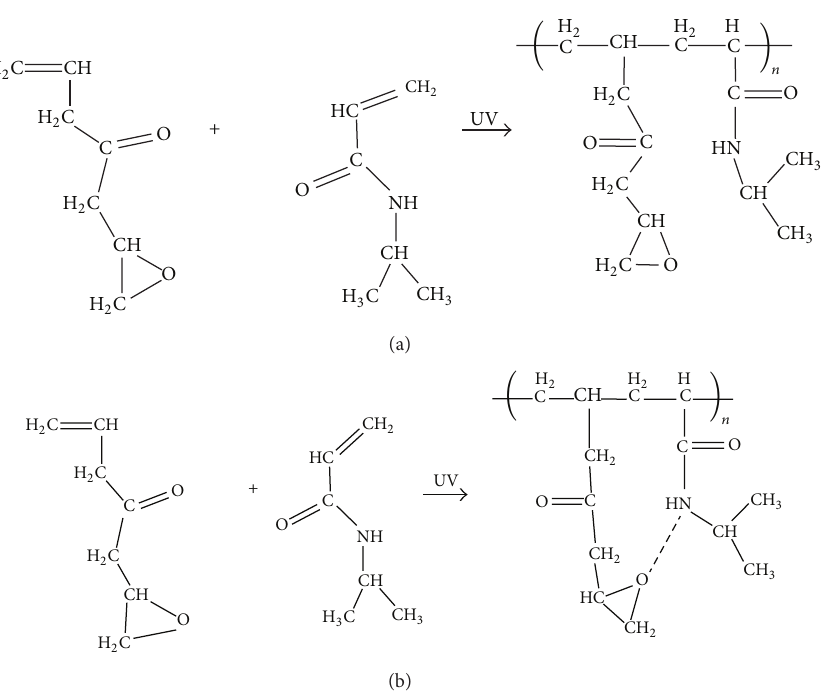
Figure 1: (a) The proposed mechanism of glycidyl methacrylate and N -isopropylacrylamide using suspension photopolymerization. (b) The possible intermolecular interaction in poly(glycidyl methacrylate-co- N